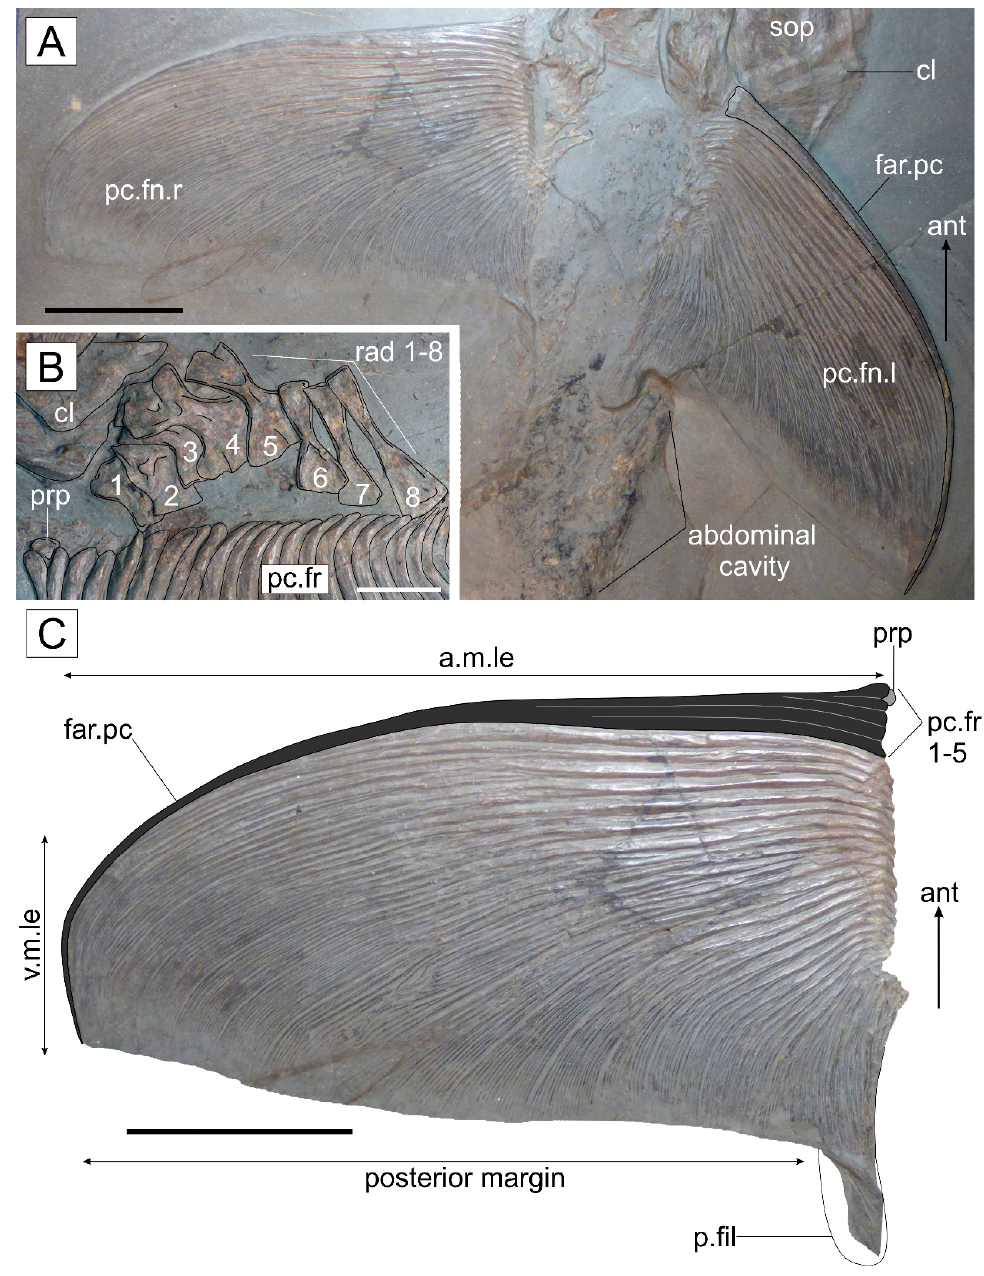
Figure 6. Germanostomus pectopteri gen. et sp. nov., endochondral pectoral girdle and pectoral fins of the holotype (SMNS 15815): ( A ) pectoral girdle showing pectoral fins prepared in ventral view; ( B ) right endochondral pectoral girdle exposing the articulated radials and small propterygium; ( C ) right pectoral fin showing the fused anterior spine of the leading edge. The posterior-most lepidotrichia of the posterior fillet have folded over during burial; the outline indicates their original extent. a.m.le, anterior margin of the leading edge; ant, anterior direction; cl, cleithrum; far.pc, fused anterior spine of the pectoral fin; p.fil, posterior fillet; pc.fn, pectoral fin (l, left; r, right); pc.fr, pectoral fin rays; prp, propterygium; rad 1–8, radials 1 to 8; v.m.le, distal margin of the fin. Scale bars = 50 ( A , C ) and 10 mm ( B ).